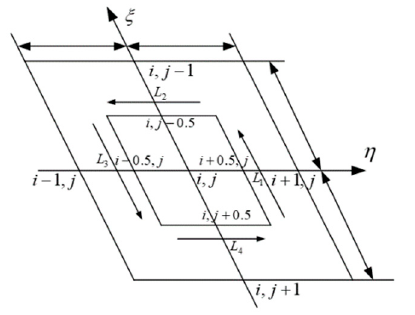
Figure 4. Diagram of continuous oil film integration area A.